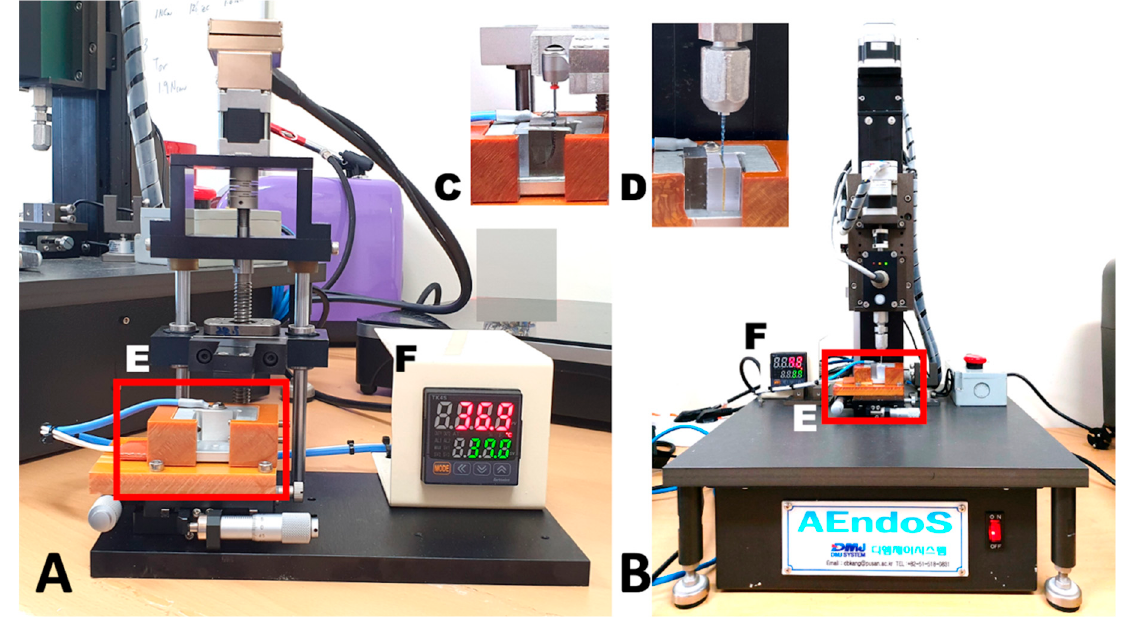
Figure 1. Test devices used in this study. ( A ) Tester (EndoC) for cyclic fatigue resistance test, ( B ) tester (AendoS) for torsional resistance test, ( C ) simulated canal in the heat generation pad, ( D ) Brass plates and polycarbonate blocks holding the file tip, ( E ) heat generation pad, and ( F ) electronic heat